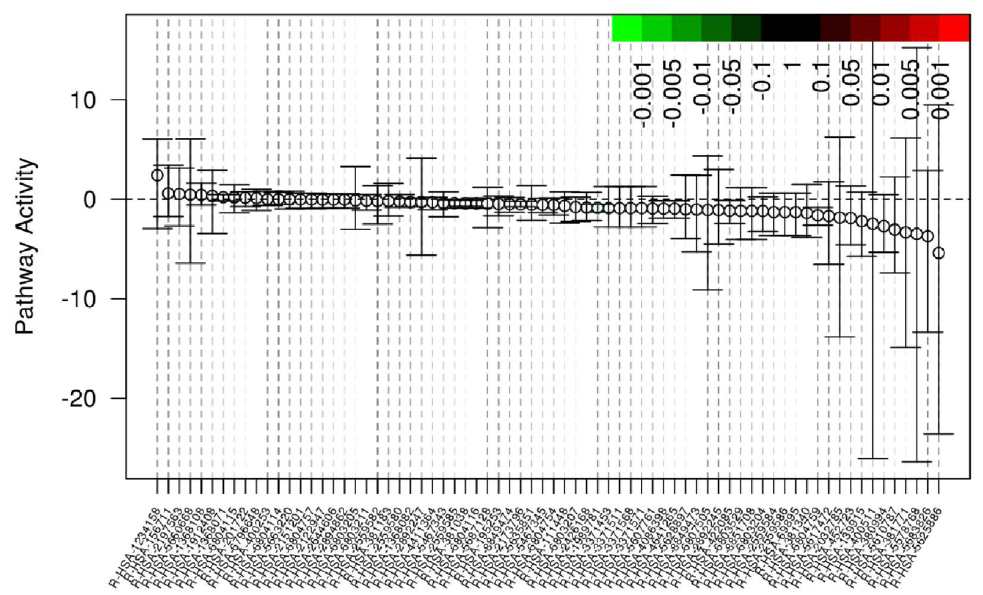
Figure 4. Arkas-Analysis Gene-Set Enrichment Plot. Gene-Set enrichment output report, each point represents the differential mean activity of each gene-set with 95% confidence intervals. The X-axis are individual gene-sets. The Y-axis is the log